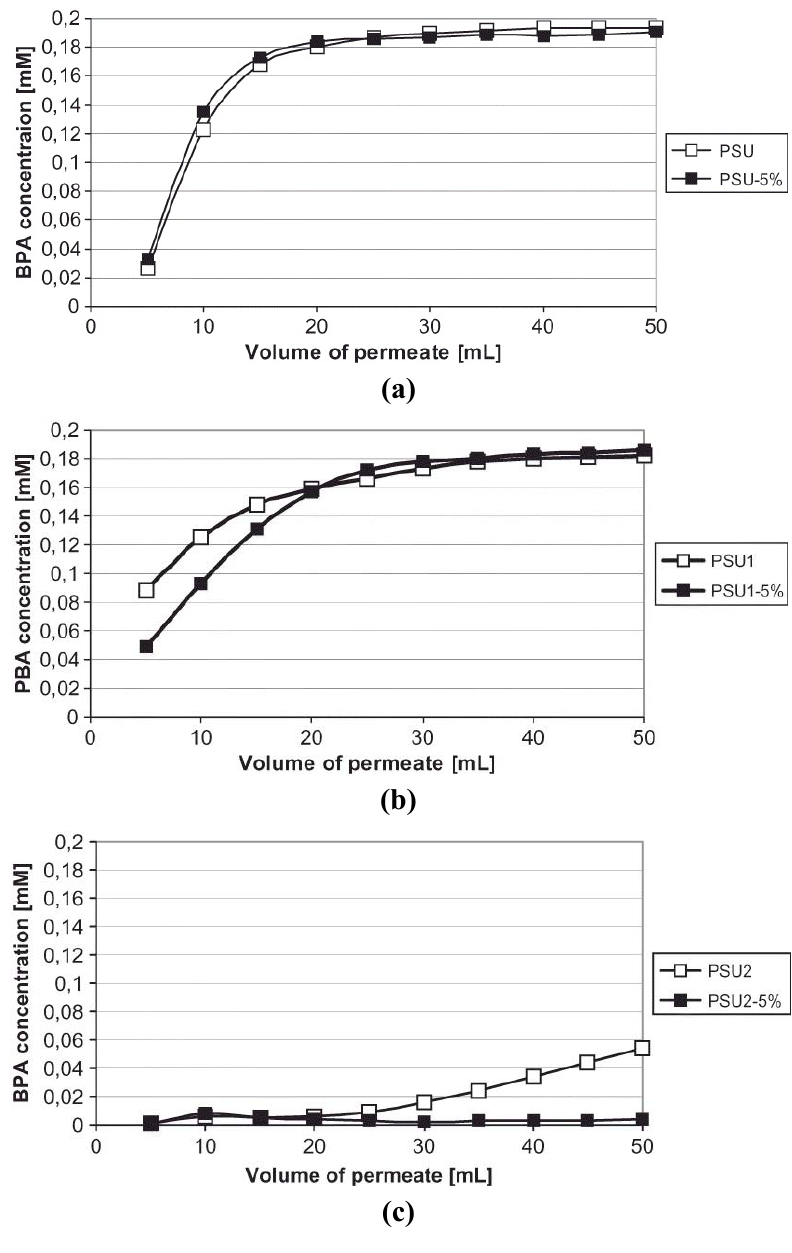
Figure 10. Permeability of PSf membranes with respect to bisphenol A. PSU has degree of sulfonation = 0.00 mol/mer; PSU1 has degree of sulfonation = 0.06 mol/mer; PSU2 has degree of sulfonation = 0.26 mol/mer; 5% is the amount of template (5 wt